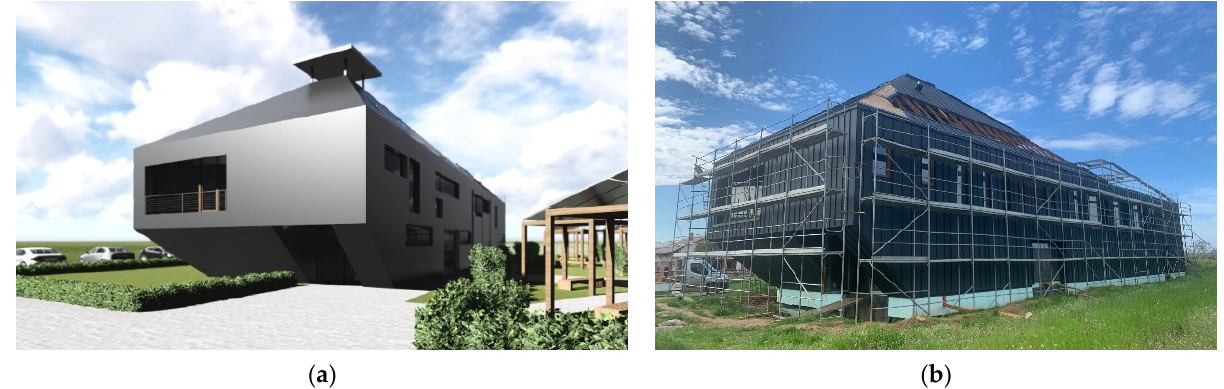
Figure 1. ( a ) Design visualization rendering and ( b ) the final building under